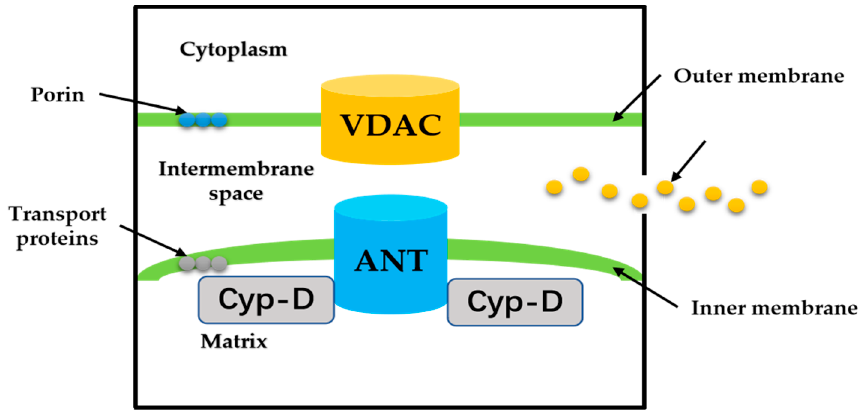
Figure 2. The proposed structure of the MPTP. Cyp-D is a small molecule in the mitochondrial matrix. VDAC on the OMM, ANT on the IMM.